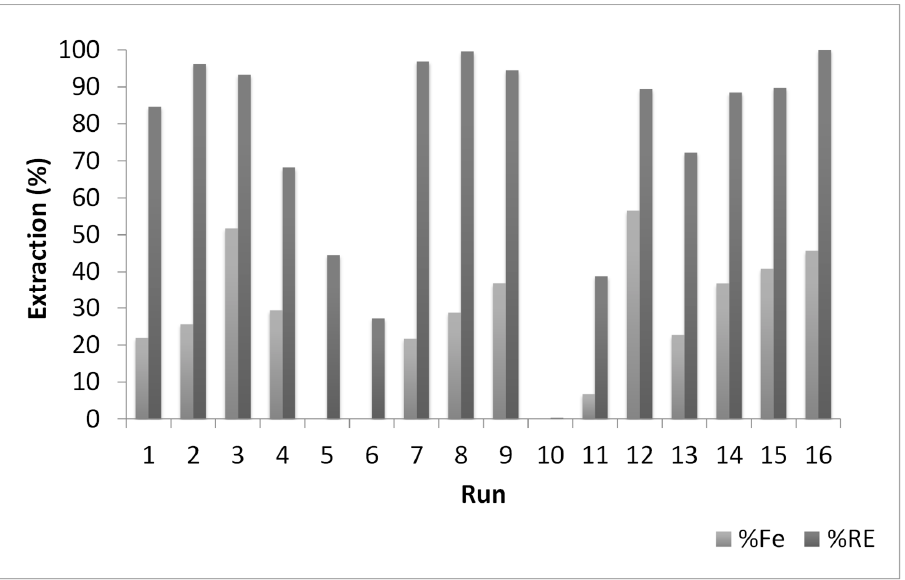
Figure 10. Extraction of REE (%RE) and Fe (%Fe)—mathematical modeling experiments.